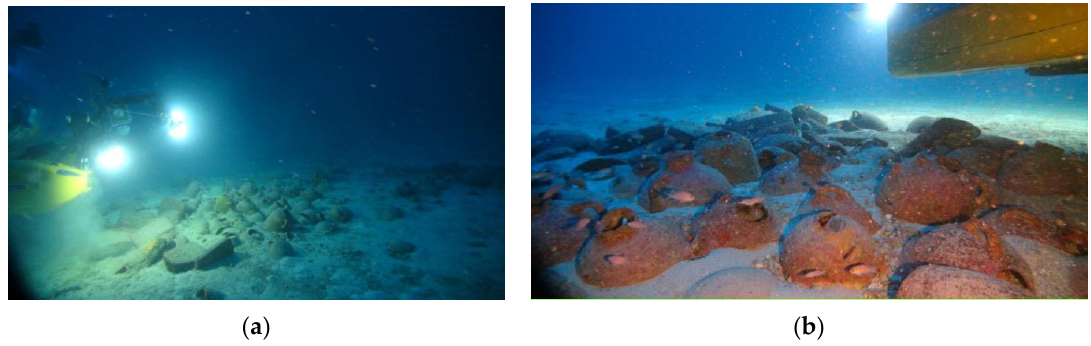
Figure 3. Examples of the wreck images taken by the ROV Super-Achille deployed during the photogrammetric survey carried out from the submarine Rémora 2000. The mixed” cargo is visible on both ( a ) and ( b ) images.